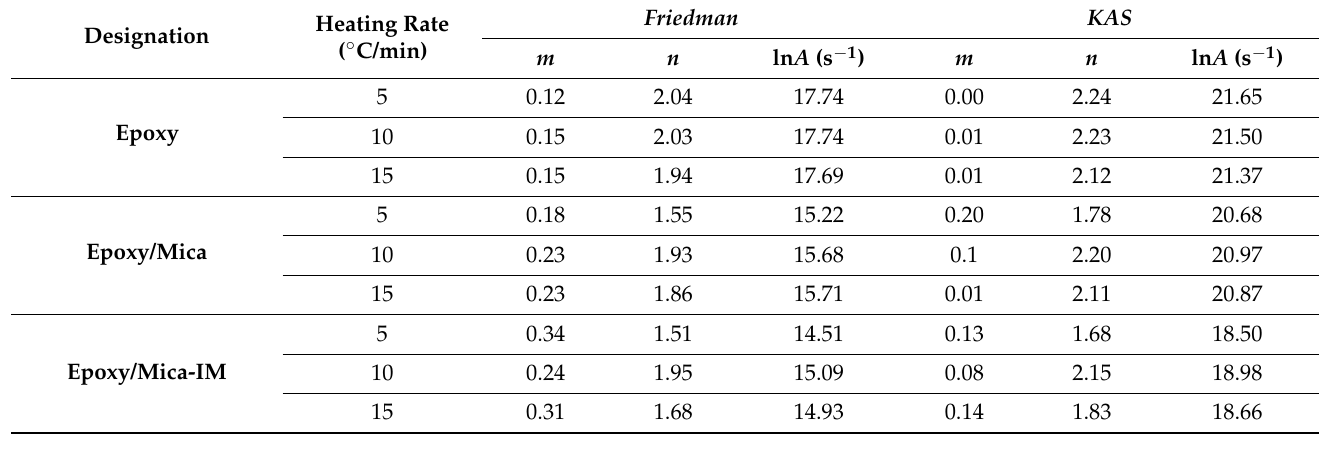
Table 2. Kinetic parameters of the studied samples obtained using Friedman and KAS isoconversional approaches.